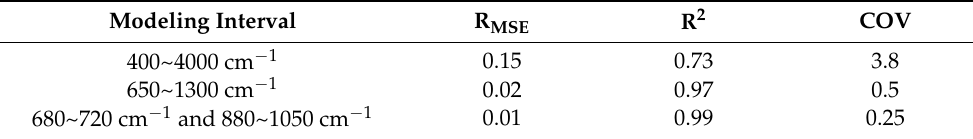
Table 4. Sensitivity analysis for the impact of wavelength range. Modeling